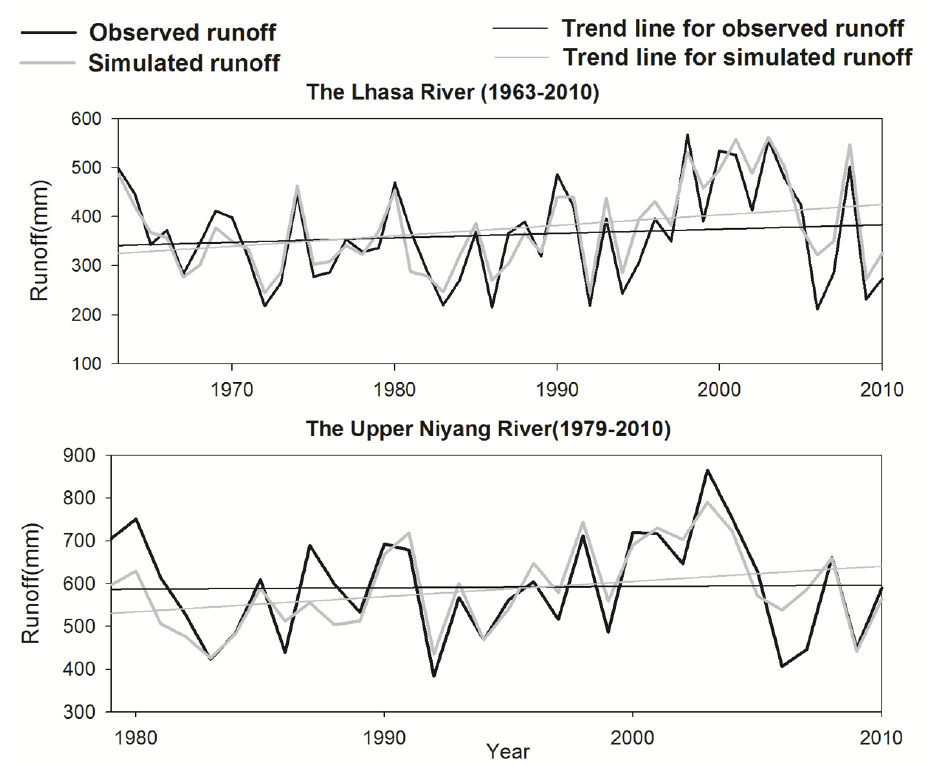
Figure 4. Variations of the annual observed and VIC simulated runoff, and their linear trends during the historical period.